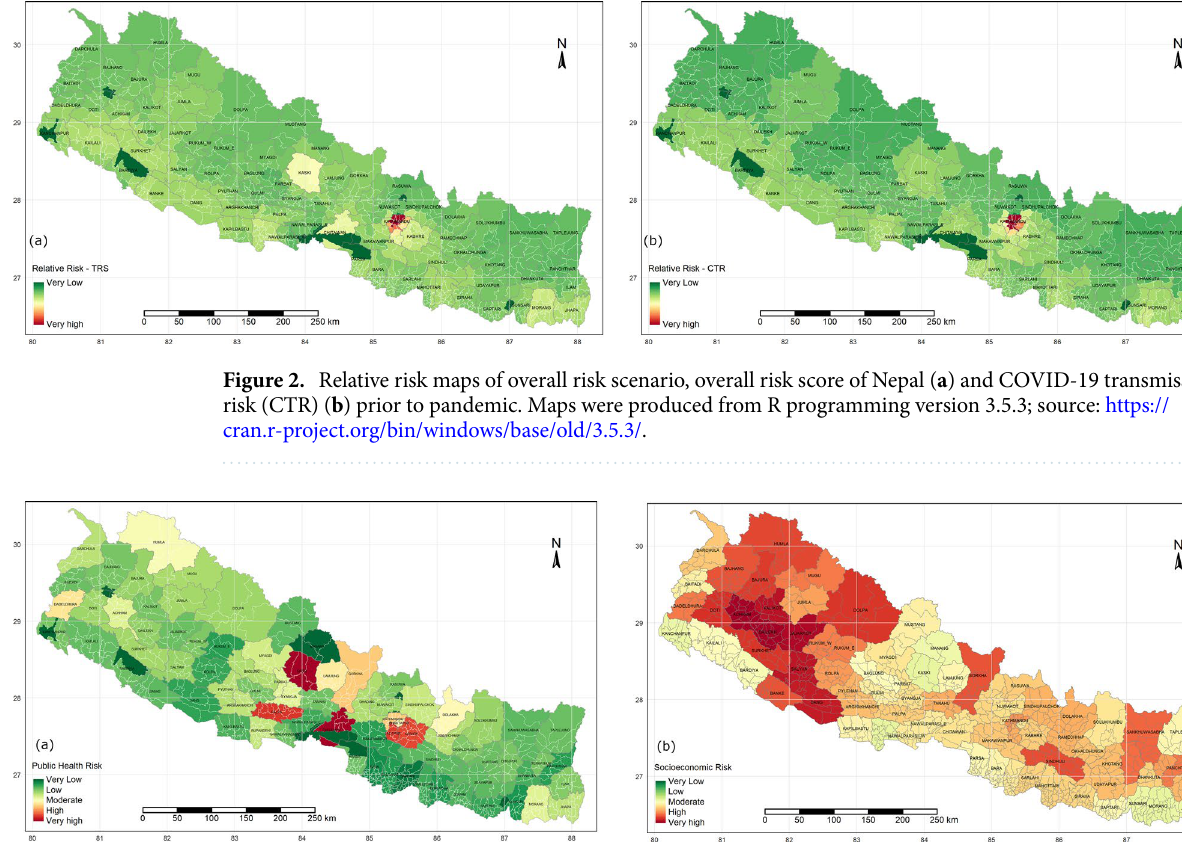
Figure 3. Public health risk ( a ) and socioeconomic risk ( b ) of Nepal for COVID-19 pandemic. Maps were produced from R programming version 3.5.3; source: https ://cran.r-proje ct.org/bin/windo